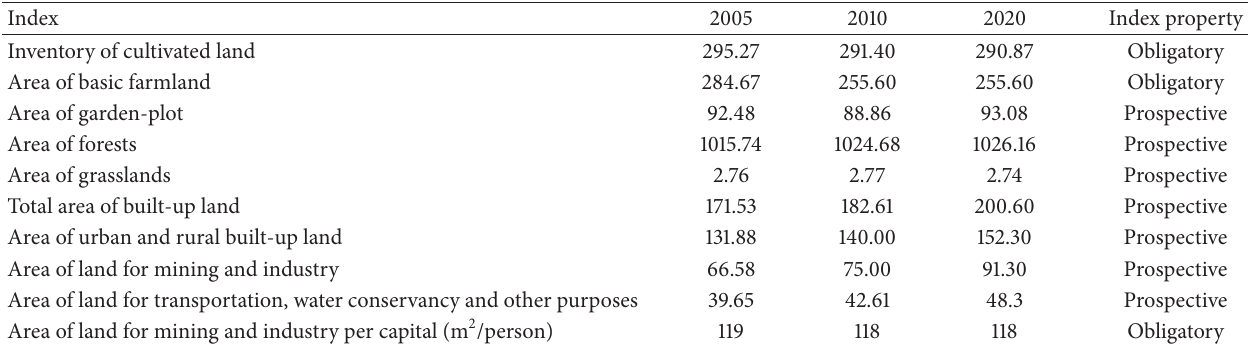
Table 2: Major control indicators of land use in Guangdong